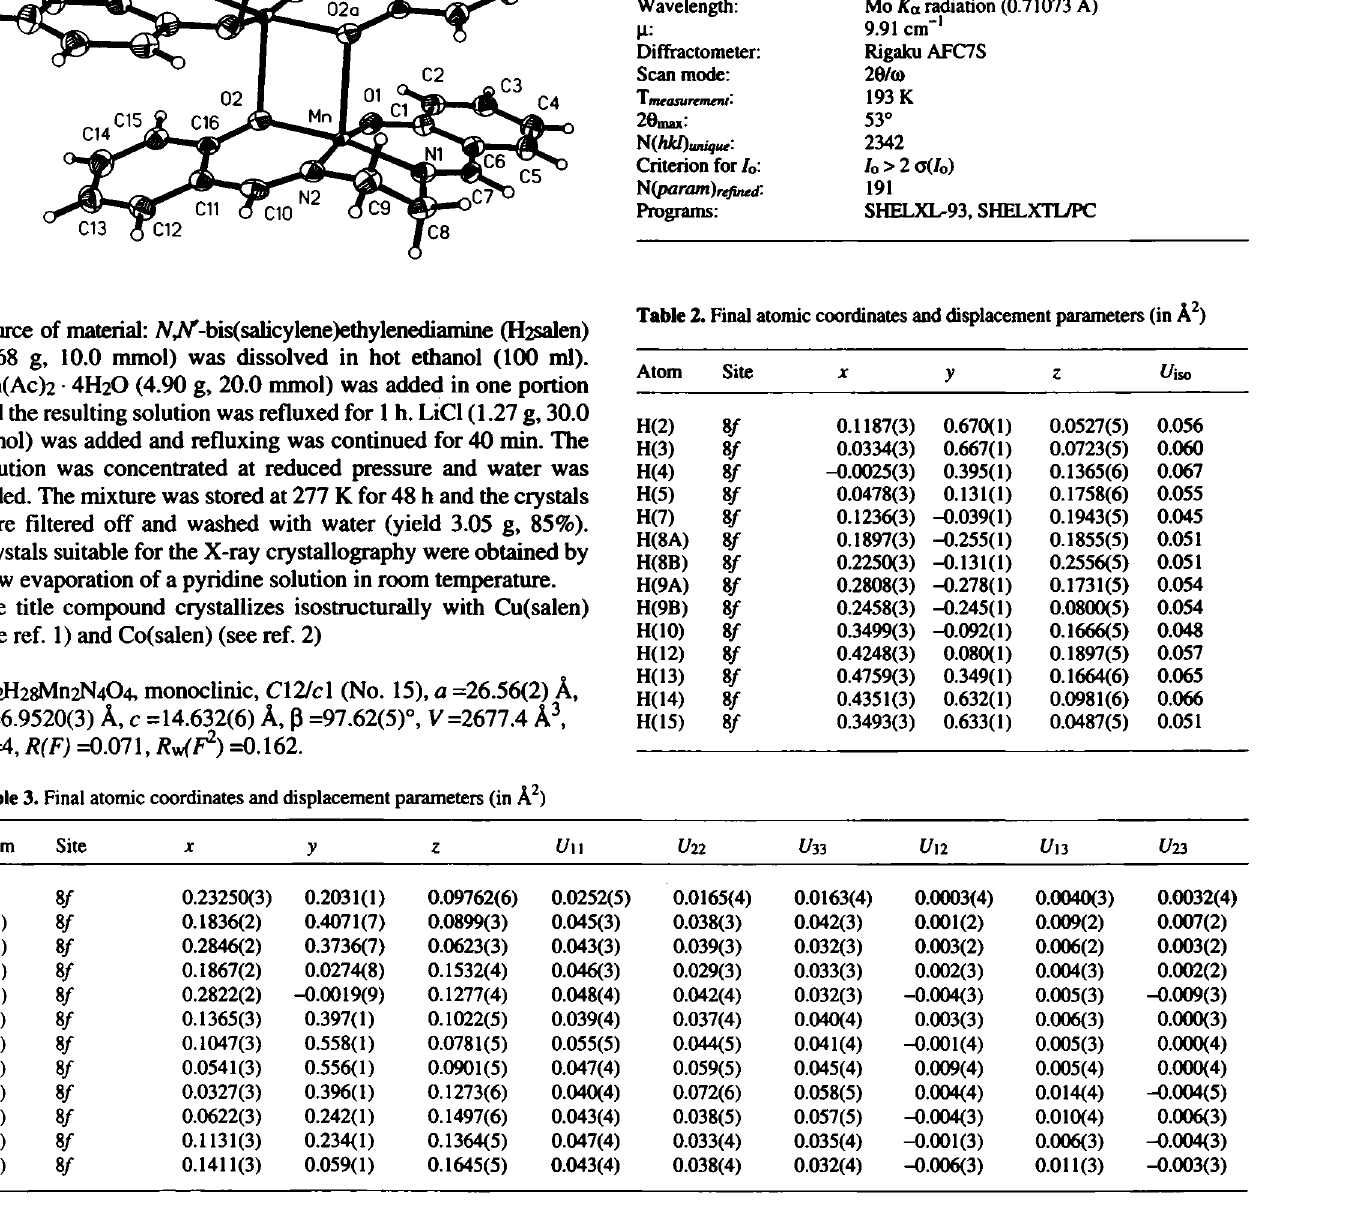
Table 1. Parameters used for the X-ray data collection Crystal: